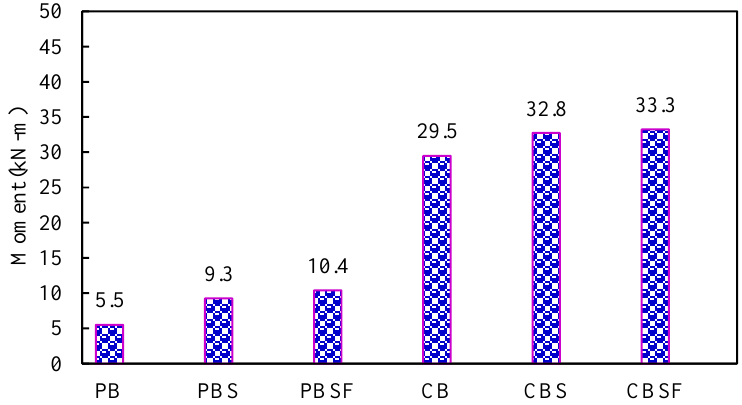
Figure 16. Comparison of the lateral buckling moments of the beams.